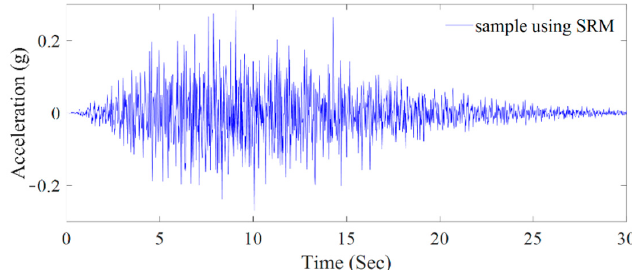
Figure 7. Typical sample by SRM.